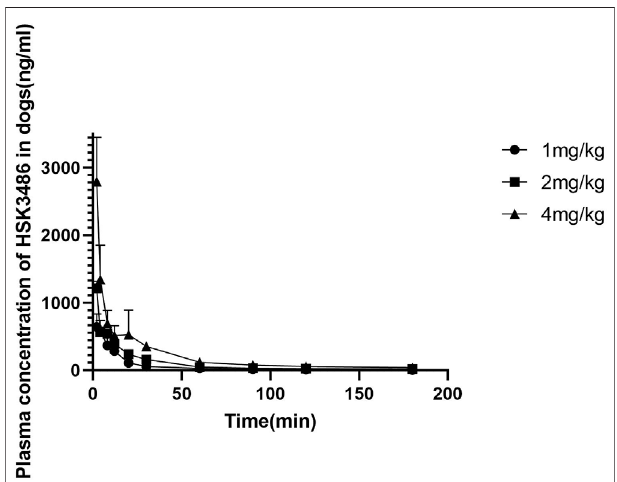
FIGURE 5 | Mean plasma concentration of HSK3486 by time after intravenous bolus injection in beagle dogs. Data are mean ± SD ( n = 6). Dogs (3/sex/group) were given HSK3486 at doses of 1, 2, or 4 mg/kg by IV injection. Blood samples were obtained from each animal at pre-dose and at 2, 4, 8, 12, 20, 30, 60, 90,120, 240, and 360 min after the dose.